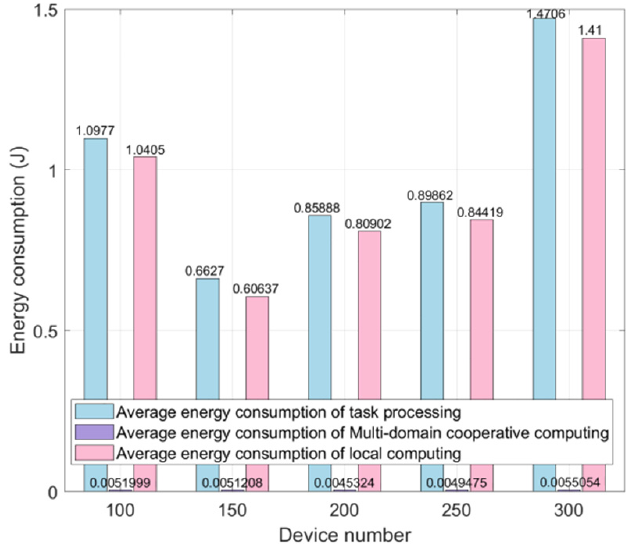
Figure 7. Variations in energy consumption across multiple task processing stages under various industrial intelligent terminals.